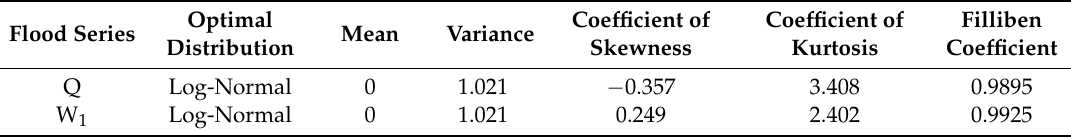
Table 2. The residuals of the optimal distributions and corresponding Filliben